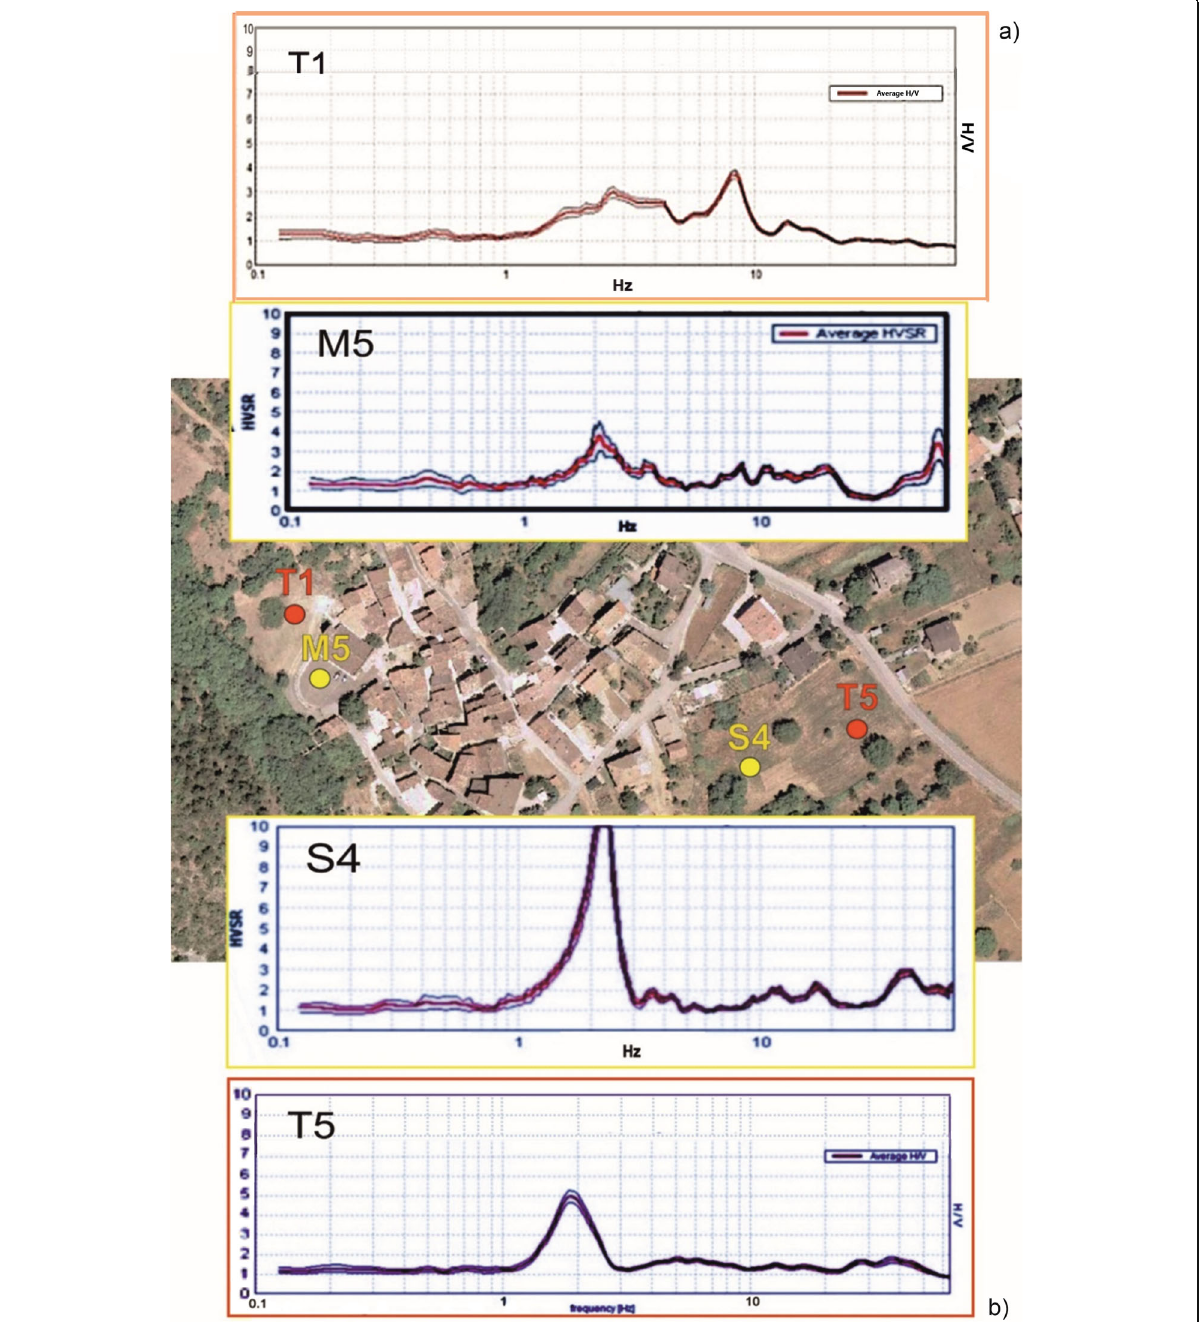
Fig. 8 a H/V measurements at two neighbor points at Tussillo center: T1 (this study) and M5 (DPC). b H/V measurements performed by the Tromino at T5 (this study) and at S4 (DPC) under similar ground